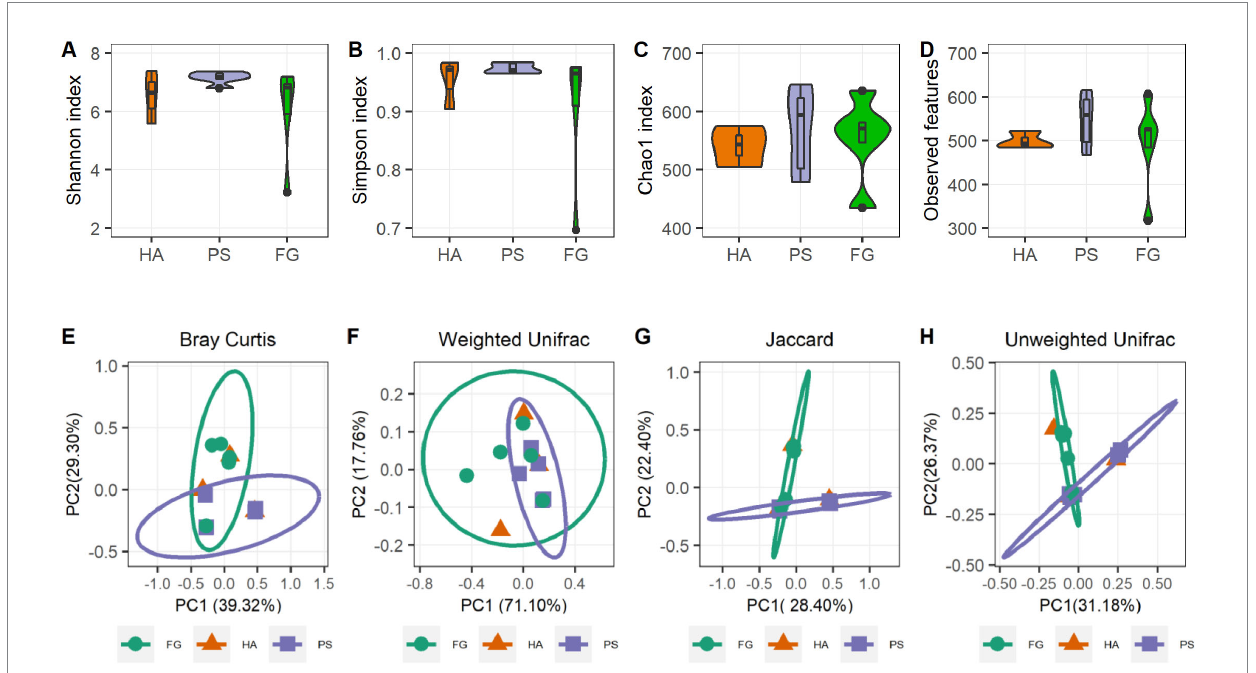
FIGURE 1 Rumen microbiota diversities of goats grouped by different forage treatments. Comparison of the diversity (Shannon and Simpson indices) (A,B) and richness (Chao1 and Observed features) (C,D) of the rumen microbiota community. The overall rumen microbiota structures showed by principal coordinate analysis (PCoA) of Bray Curtis distances (E) , Weighted UniFrac distances (F) , Jaccard distances (G) , and Unweighted UniFrac distances (H)